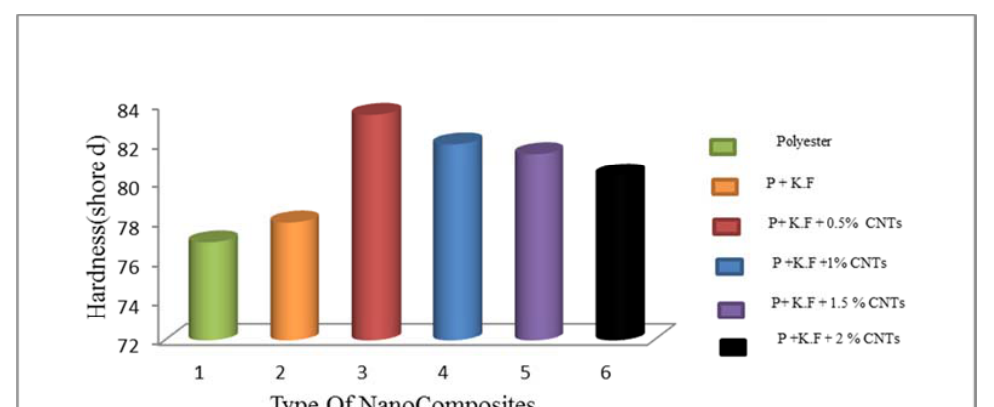
poly polye poly polye poly